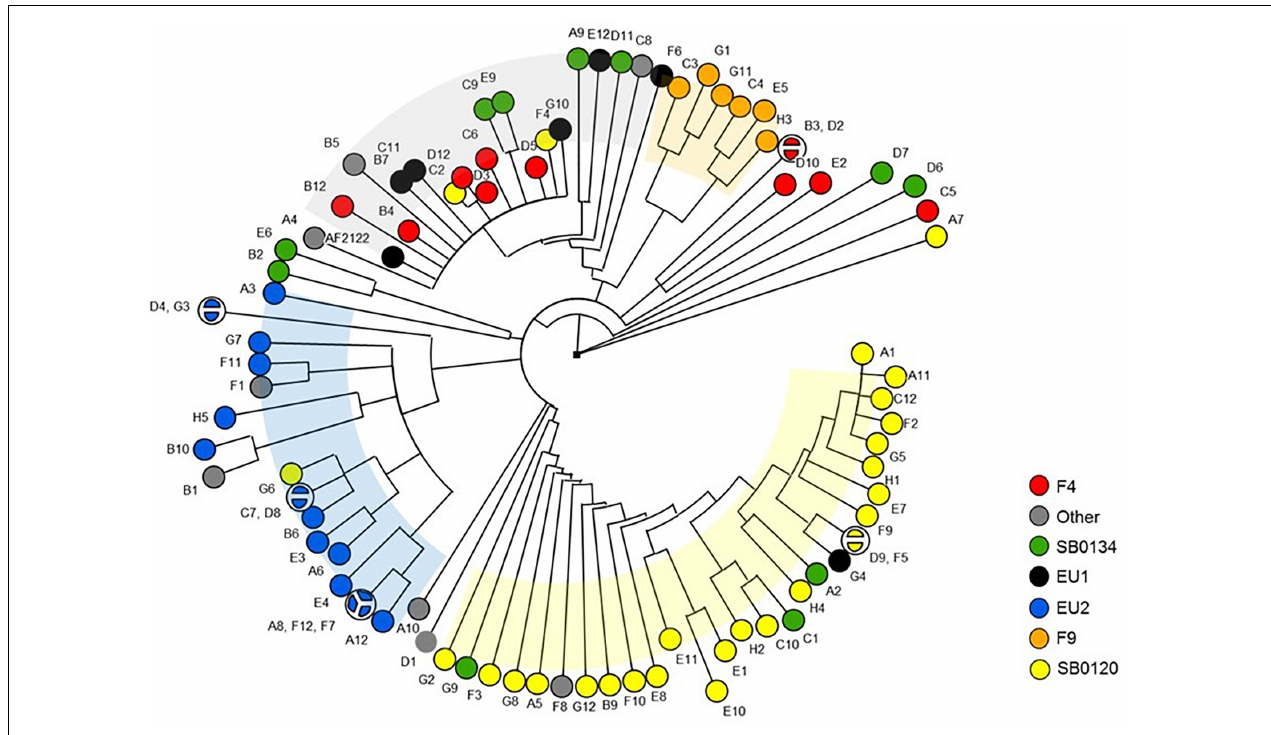
FIGURE 7 | Phylogenetic tree of the M. bovis strains based on non-synonymous SNP of virulence genes. The Majority UPGMA tree was inferred on the 392 non-synonymous SNP detected in the 137 virulence genes sequences of the 87 French M. bovis isolates in comparison to the reference strain